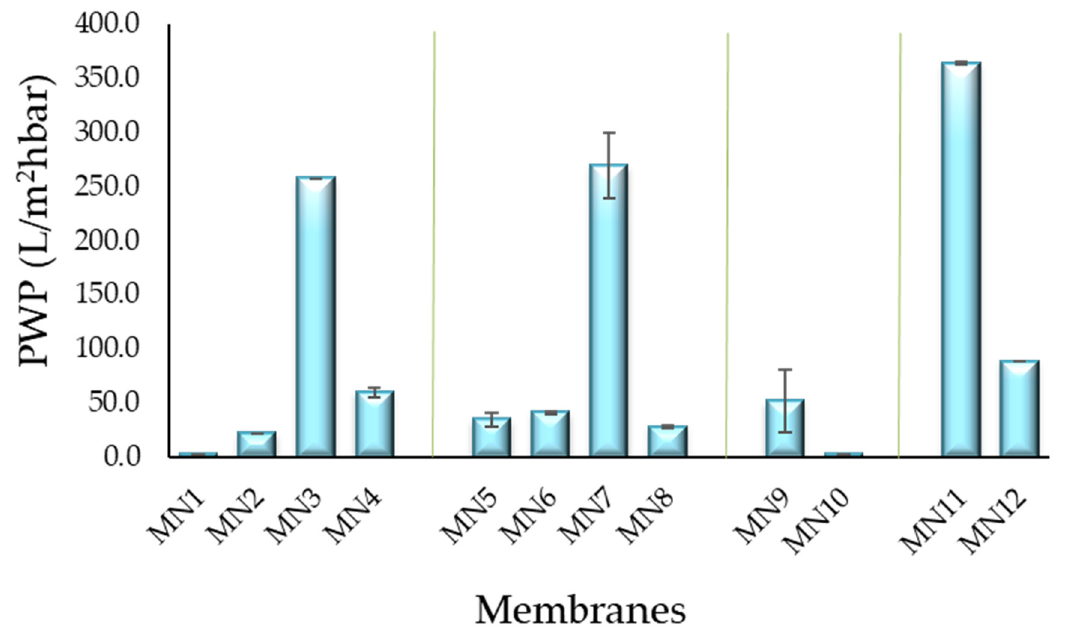
Figure 10. PWP results of investigated membranes.